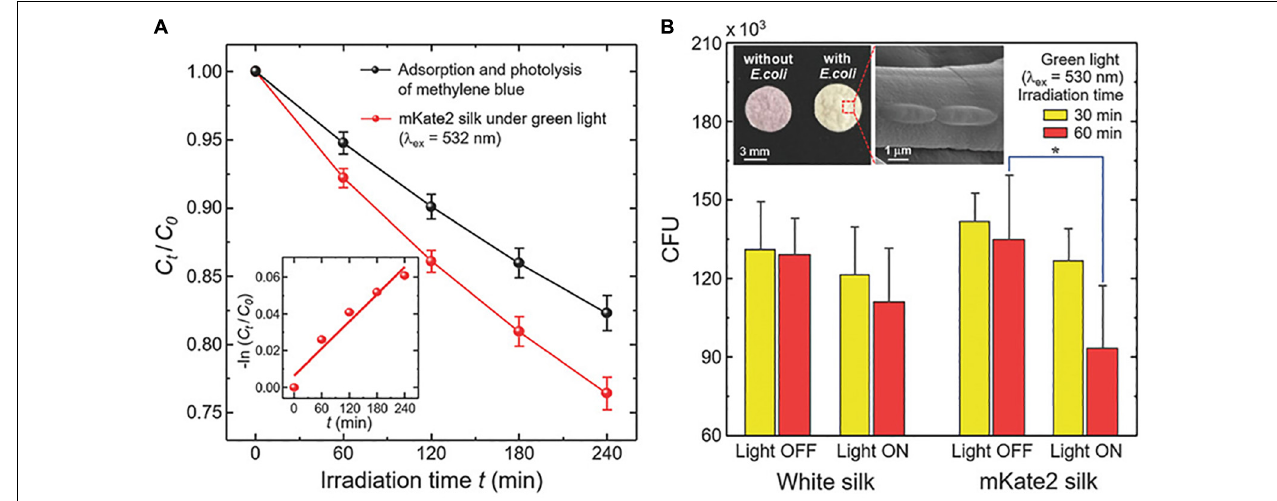
FIGURE 7 | Photocatalytic activity of mKate2 silk for degrading methylene blue and deactivating bacteria under green light excitation at ambient temperature. (A) Photodegradation of methylene blue in aqueous solutions by mKate2 silk under green light activation. (B) Colony-forming units (CFU) of live E. coli (DH5 α ). Reproduced from Leem et al. (2018) with permission from